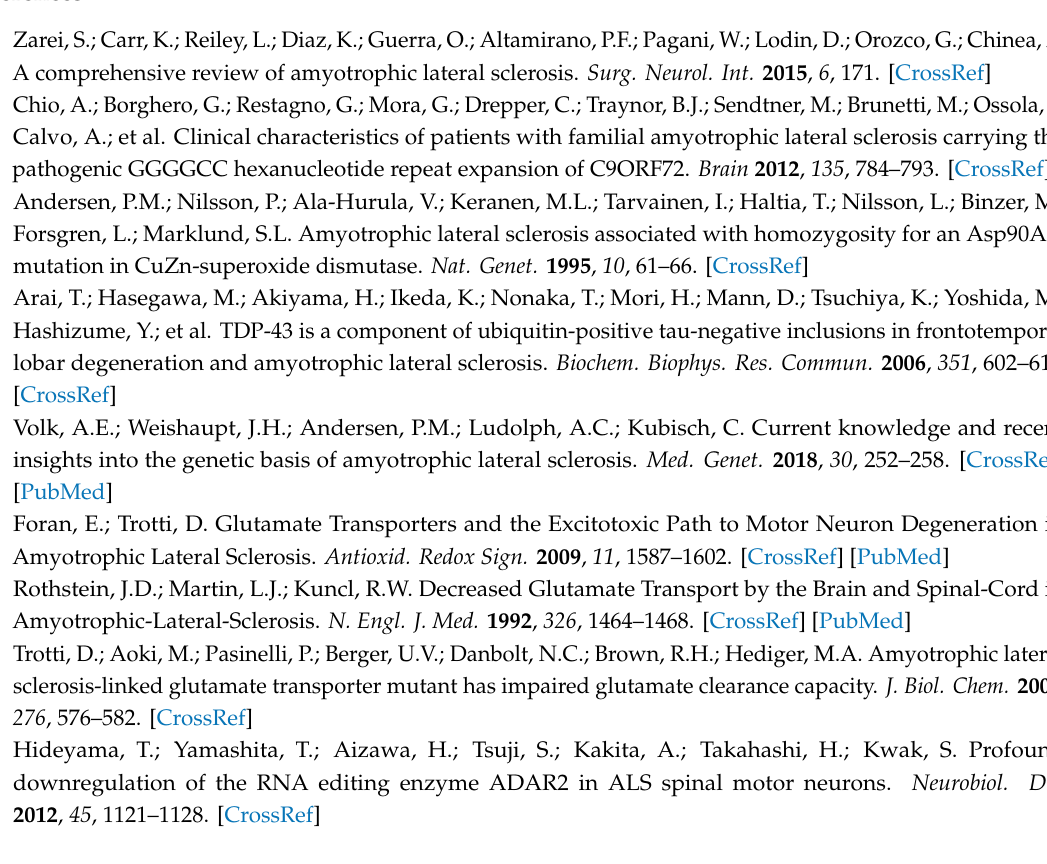
Figure S1: STRING-interactome network showing pathways related to identified genes, Table S1: Di ff erentially expressed genes between healthy- and ALS-spinal tissue, Table S2: Di ff erentially expressed genes between oculomotor and spinal tissue from healthy